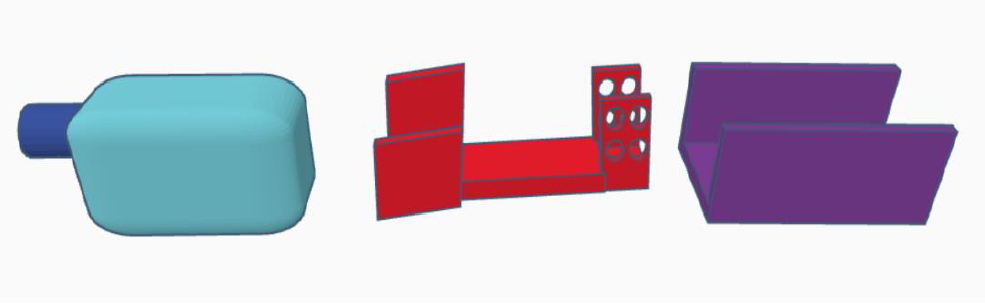
Figure 8. Parts of the exoskeleton: Concept 1 (external).